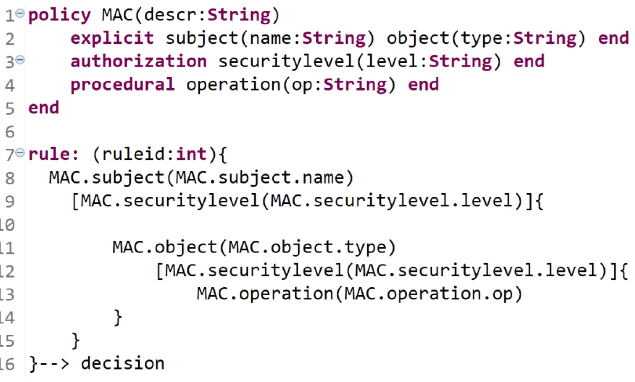
Figure 20. Example: MAC instance [3].